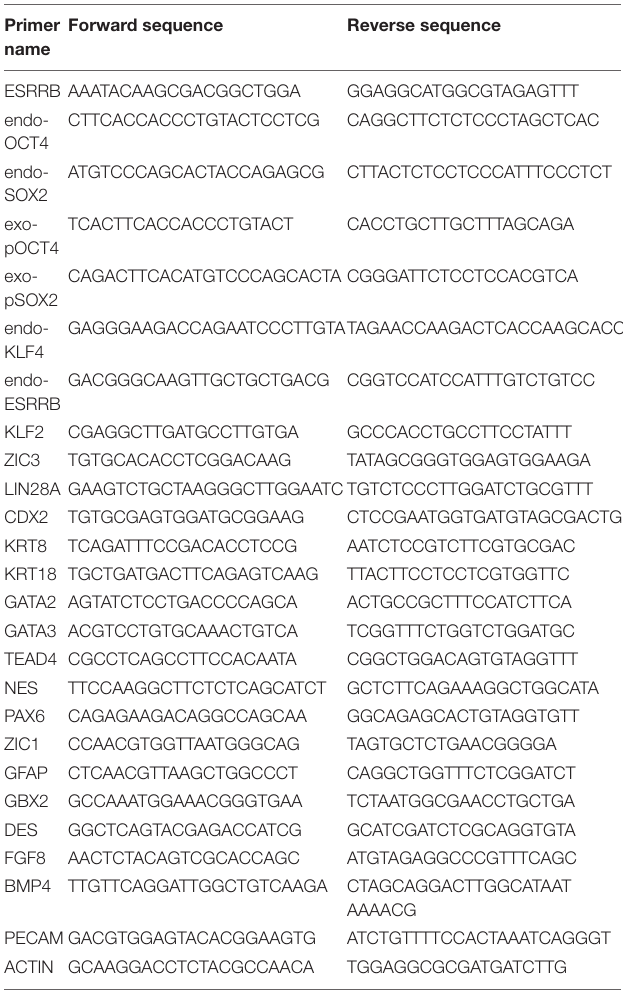
TABLE 3 | Quantitative RT (qRT)-PCR primers used in this experiment. Primer Forward sequence name